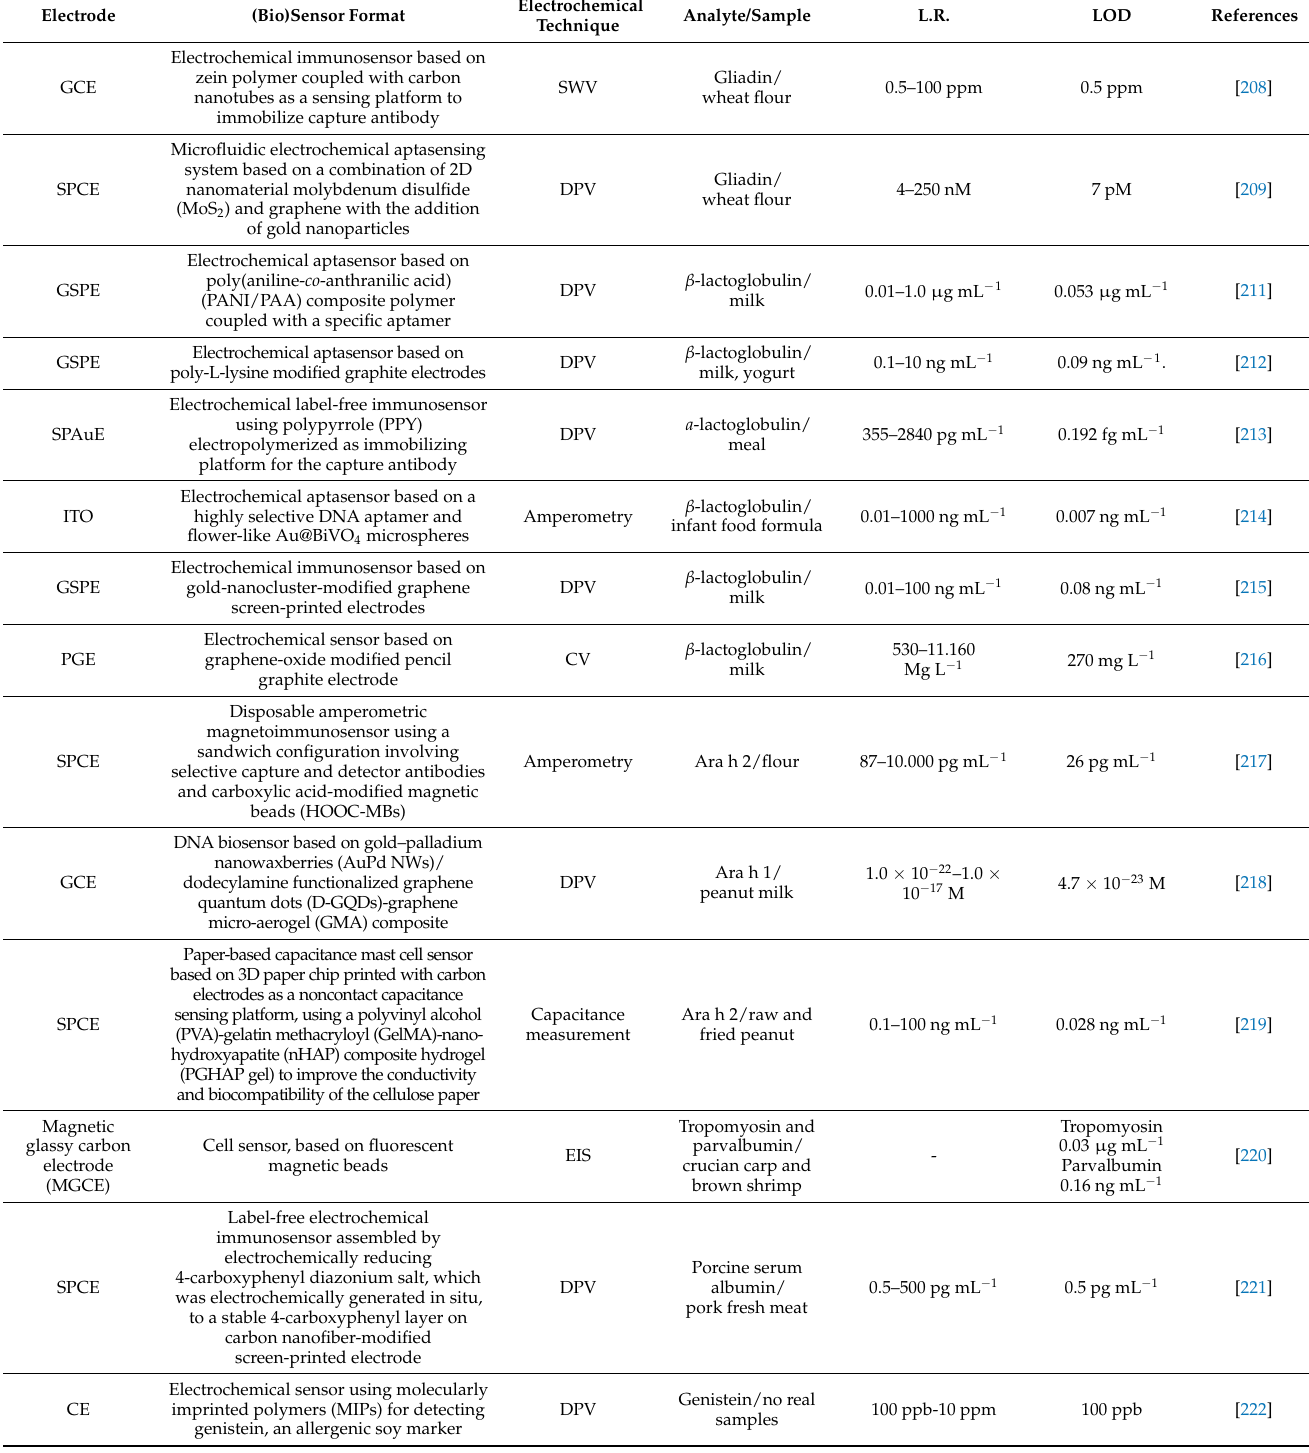
Table 6. An overview of recent electrochemical biosensors for allergens